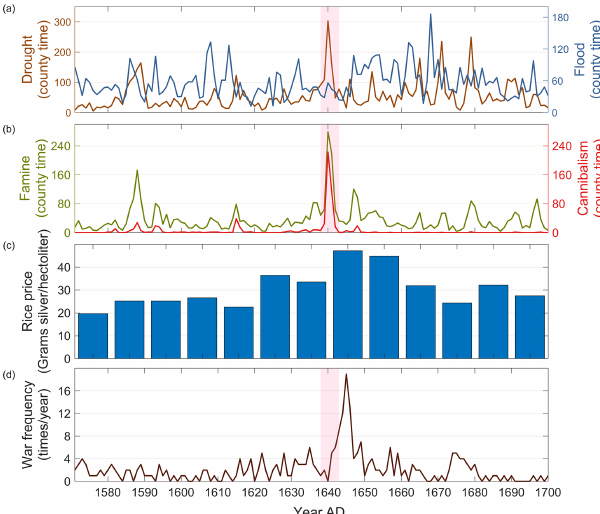
Figure 8. Chinese weather anomalies, food shortages and warfare, 1571 to 1700: (a) drought and flood data as well as incidents of (b) famine and cannibalism as reported in the Compendium of Chi- nese Meteorological Records of the Last 3000 Years (Zhang, 2004); (c) rice prices (Liu, 2015) underline the food scarcity of the early 1640s, a potential factor in favoring (d) elevated war frequencies during the period (Zhang et al.,